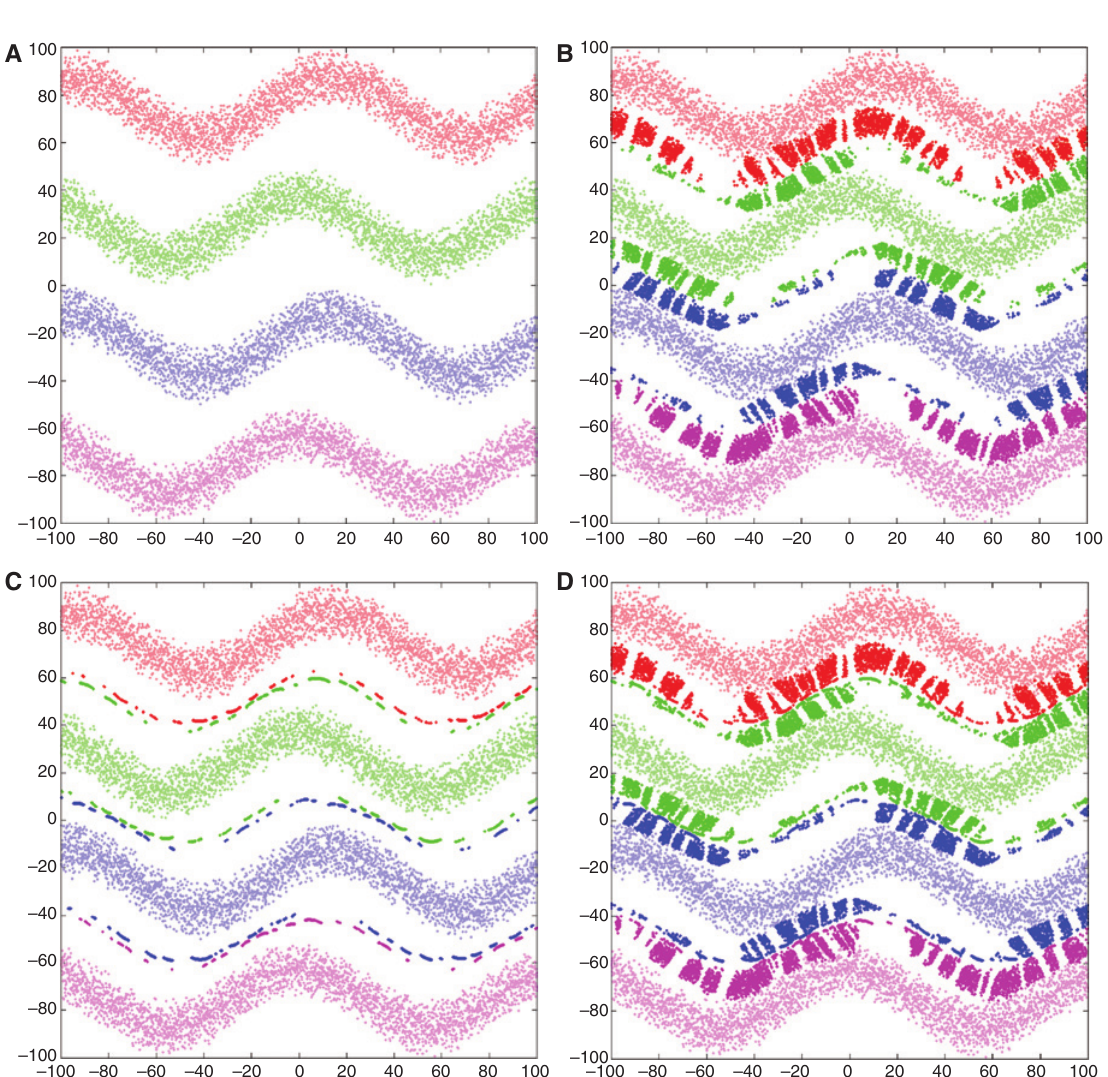
Figure 4: (A) A Four-Class Synthetic Data Set with 3200 Samples per Class with (B) FMCOVs, (C) AMCOVs, and (D) Both FMCOVs and AMCOVs